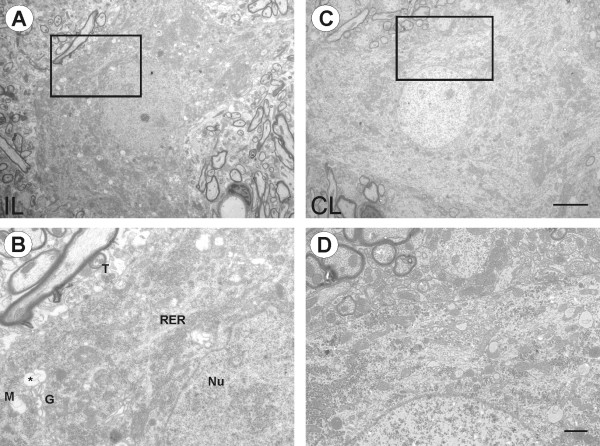
Electron photomicrographs of spinal cord motoneurons of IFNγ-KO mice. (A) α-motoneurons in the lesioned side. Boxed area is shown at higher magnification in (B). The cytoplasm and nuclei are more electron dense and cytoplasmatic organelles are disorganized. Note the presence of numerous vacuoles in the perikaryon (asterisk) and the irregular contour of nuclear membrane. (C) α-motoneurons in the contralateral side. (D) Higher magnification shows the cell less electron dense and with some vacuoles in the cytoplasm. T, synaptic terminal; M, mitochondria; RER, rough endoplasmic reticulum, Nu, nucleus; G, golgi apparatus. Scale bar: 5 μm (A and C), 1 μm (B-D).